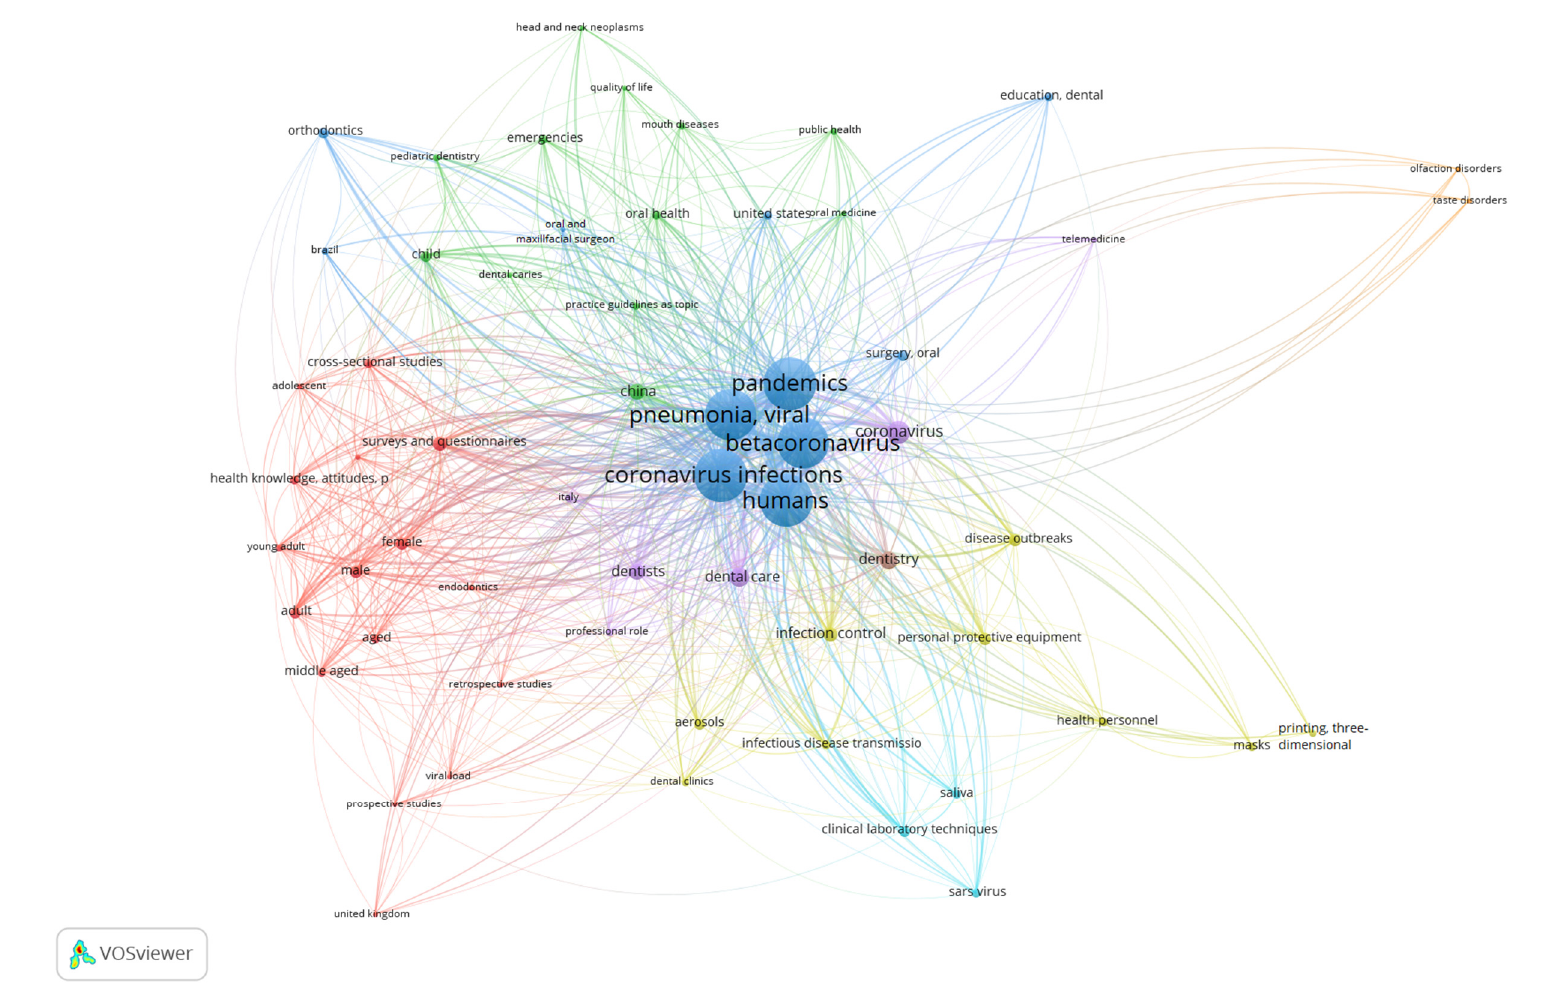
Figure 5. Network visualization of the keywords showing 60 nodes and 8 clusters.